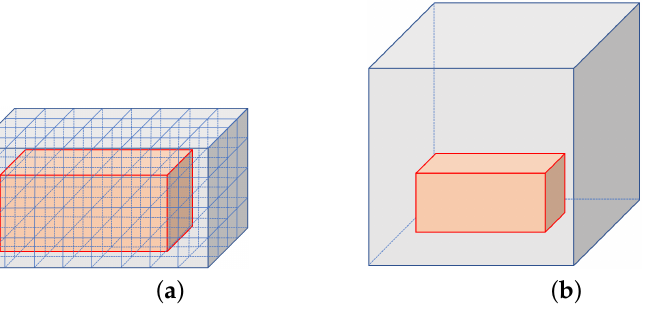
Figure 9. Space–time cubes covered by grid of different sizes. ( a ) Schematic diagram of a query at a high subdivision level. ( b ) Schematic diagram of a query at a low subdivision